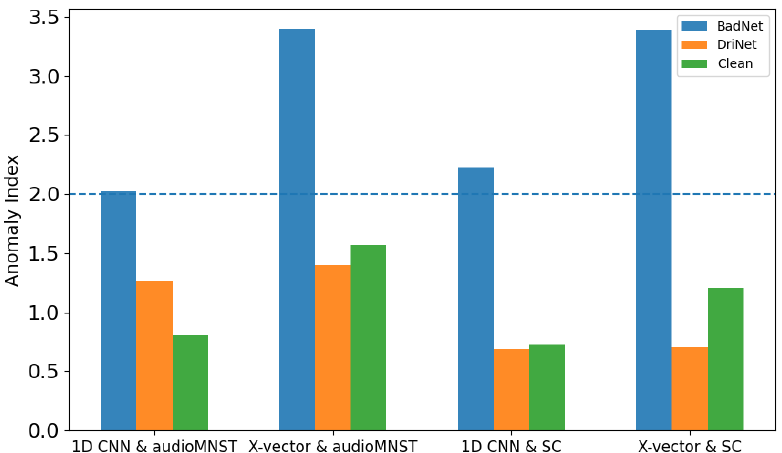
Figure 2. Anomaly index of BadNet, DriNet, and cthe lean model. The lower, the better; the blue- dotted line is the threshold used. SC denotes the speech commands